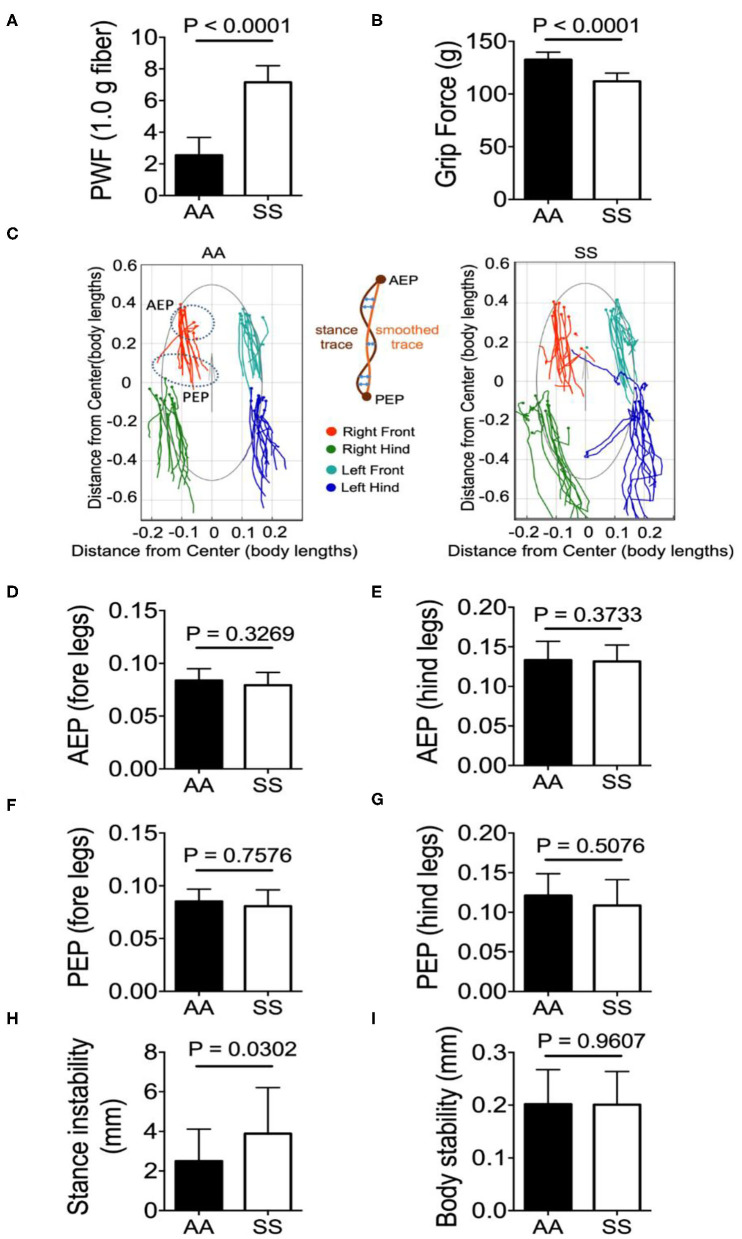
Sickle mice with chronic pain present stance instability. Hyperalagesia and gait parameters were measured in the test groups of untreated HbSS-BERK sickle (SS) and HbAA-BERK control (AA) mice. (A) Mechanical hyperalgesia assessed by Paw Withdrawal Frequency (PWF) in response to 1.0-g von Frey filaments. Mechanical and (B) deep tissue hyperalgesia assessed by a computerized grip-force measure. (C) shows representative stance trace of one sickle (right) and control mouse (left) walking at 21.59 and 21.20 cm/s, respectively. The traces were determined by measuring the position of the stance phase footprints relative to the body center. The anterior extreme position (AEP) indicates stance onset and the posterior extreme position (PEP) indicates stance offset (positions encircled by a dashed line for the right fore paw). For each stance trace (maroon), a smoothed trace is generated (using data from every five frames; yellow trace), and the average of the difference between these two lines (orange arrows) corresponds to the stance instability. (D,E) Perpendicular AEP and (F,G) perpendicular PEP plots for both fore and hind legs, respectively. (H,I) show stance instability and body instability, respectively. Gait parameters were analyzed using Student's unpaired two-tailed t-test. Significance was determined by t-test (unpaired, two-tailed). A p < 0.05 was considered statistically significant. All data are represented as mean ± SEM. [n = 7 per group in (A,B,D–I)].